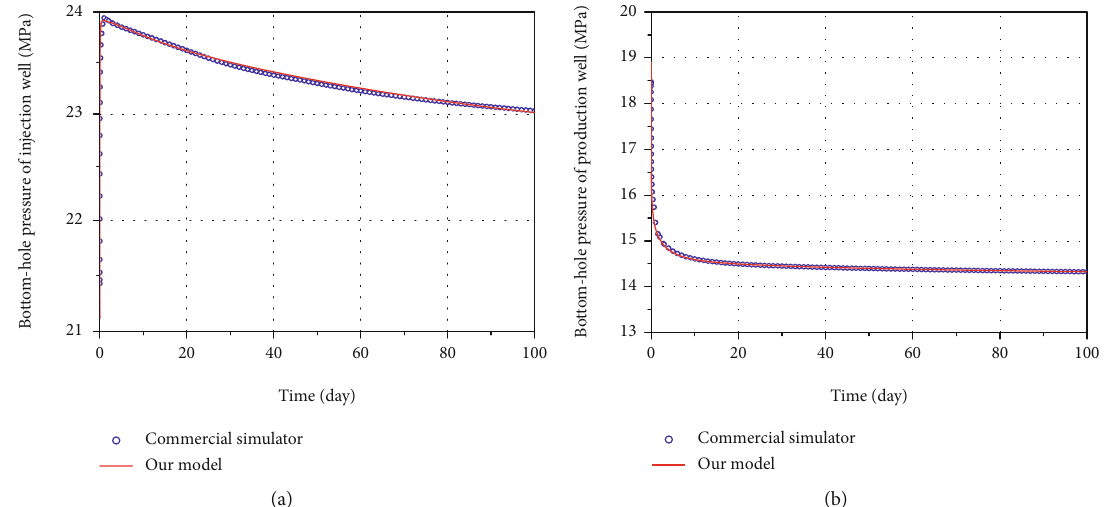
Figure 8: Comparison between our model and a commercial simulator: (a) bottom-hole pressures of an injection well computed by our model and a commercial simulator; (b) bottom-hole pressures of a production well computed by our model and a commercial simulator.